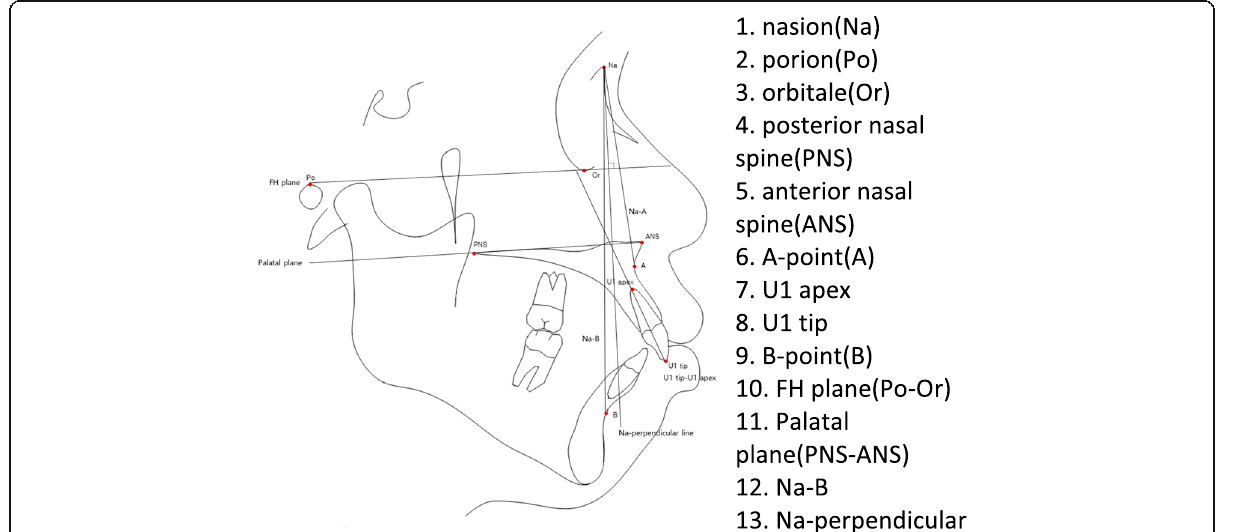
Fig. 1 Landmarks and reference lines used in cephalometric analysis